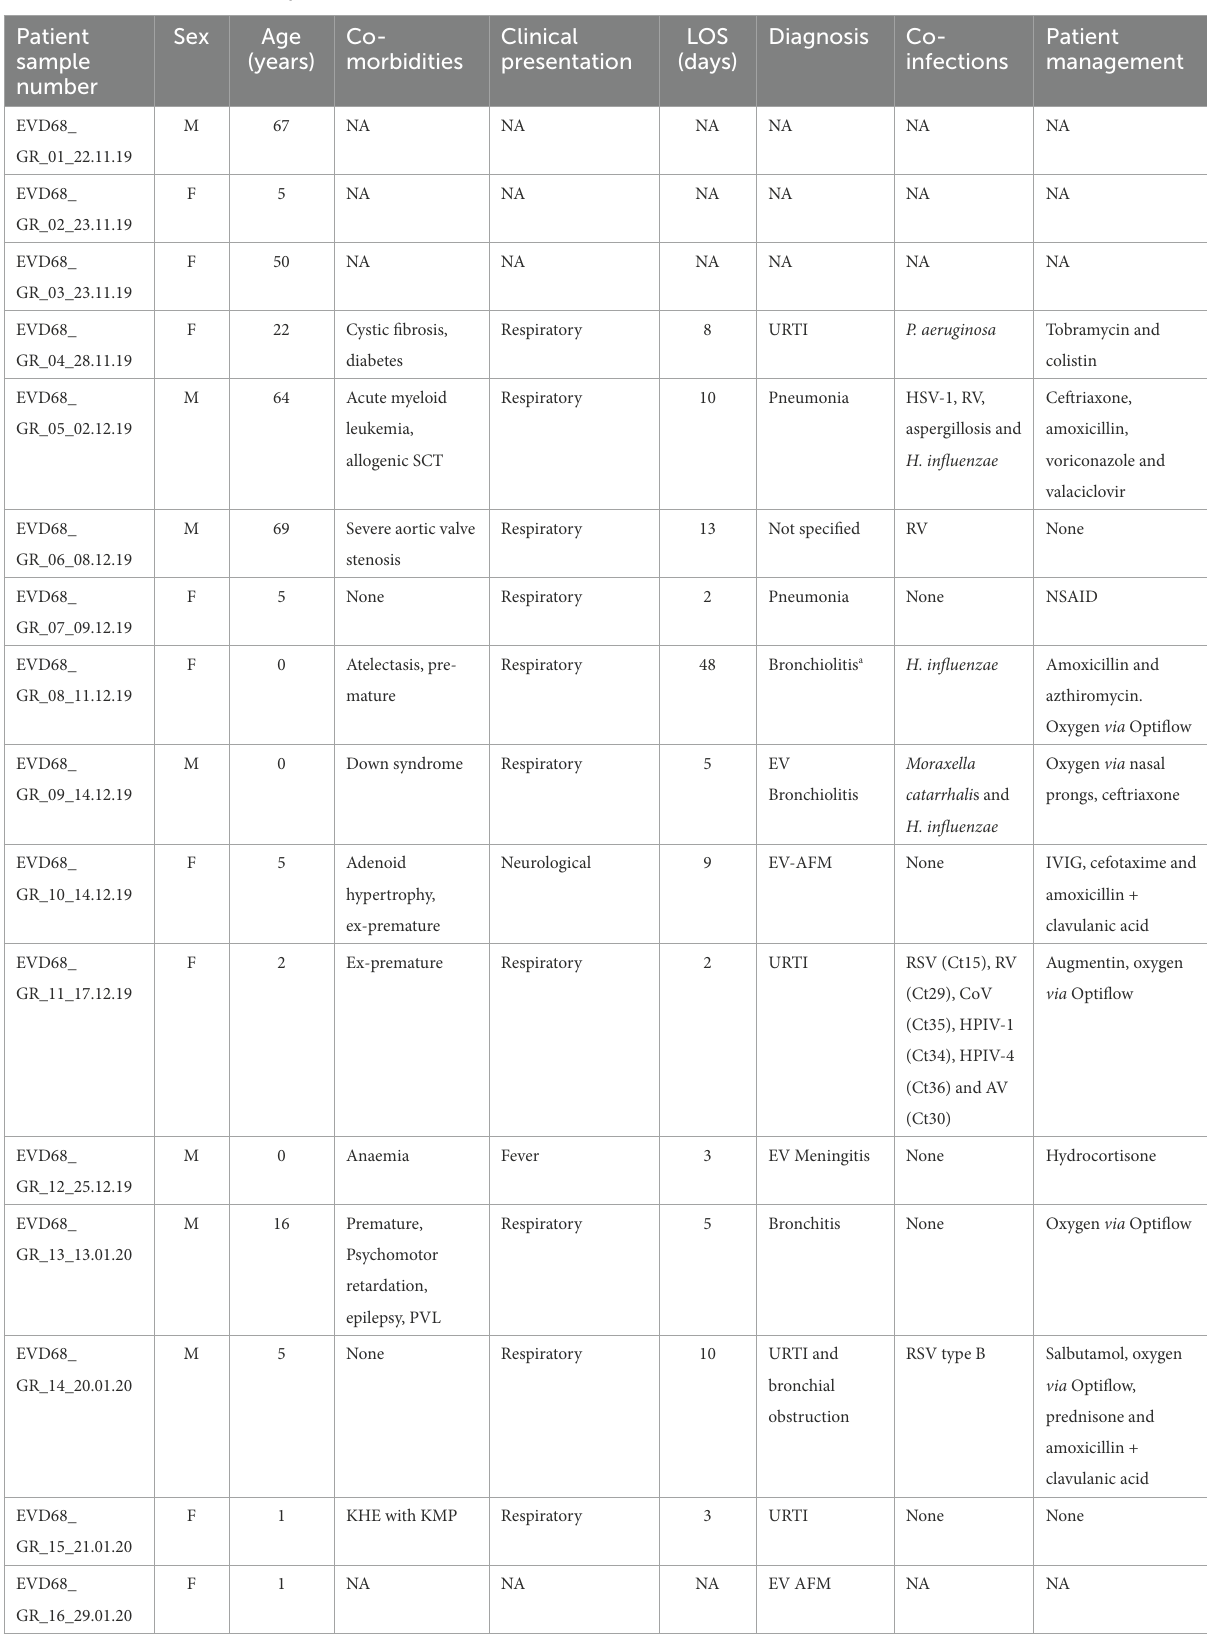
TABLE 1 Clinical characteristics of patients with an enterovirus D68 detection. Patient